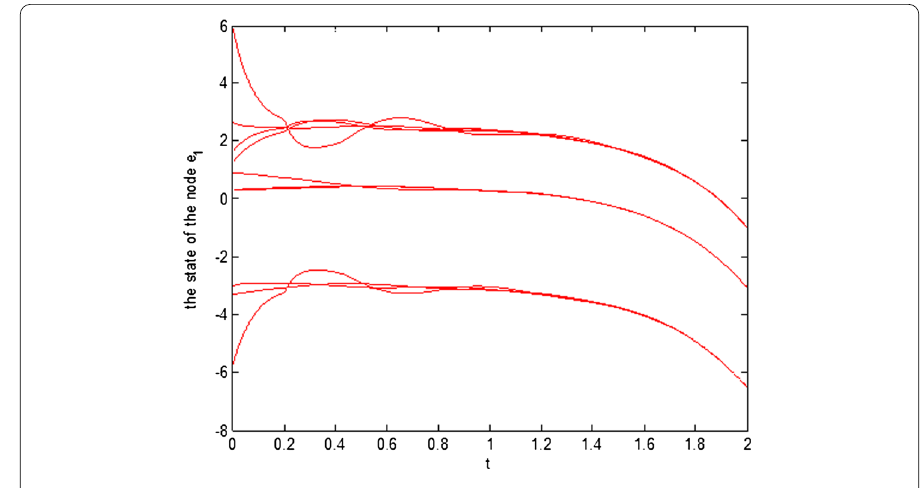
Figure 1 The state of the node e 1 without controller